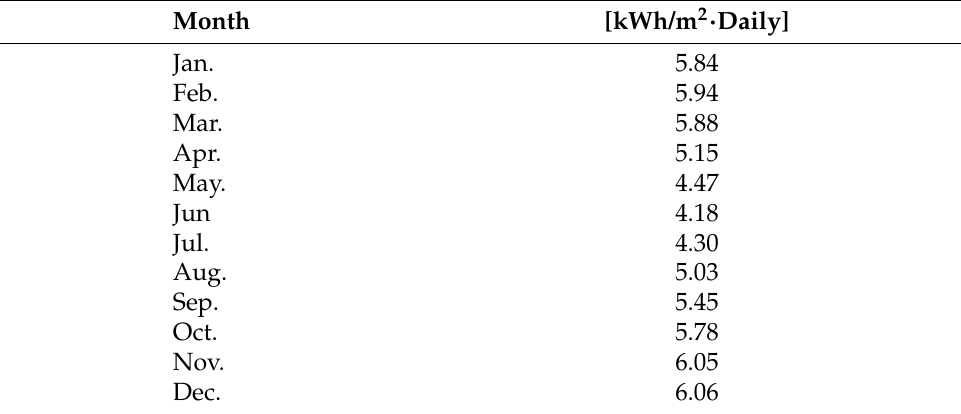
Table 2. Daily heat stroke, monthly